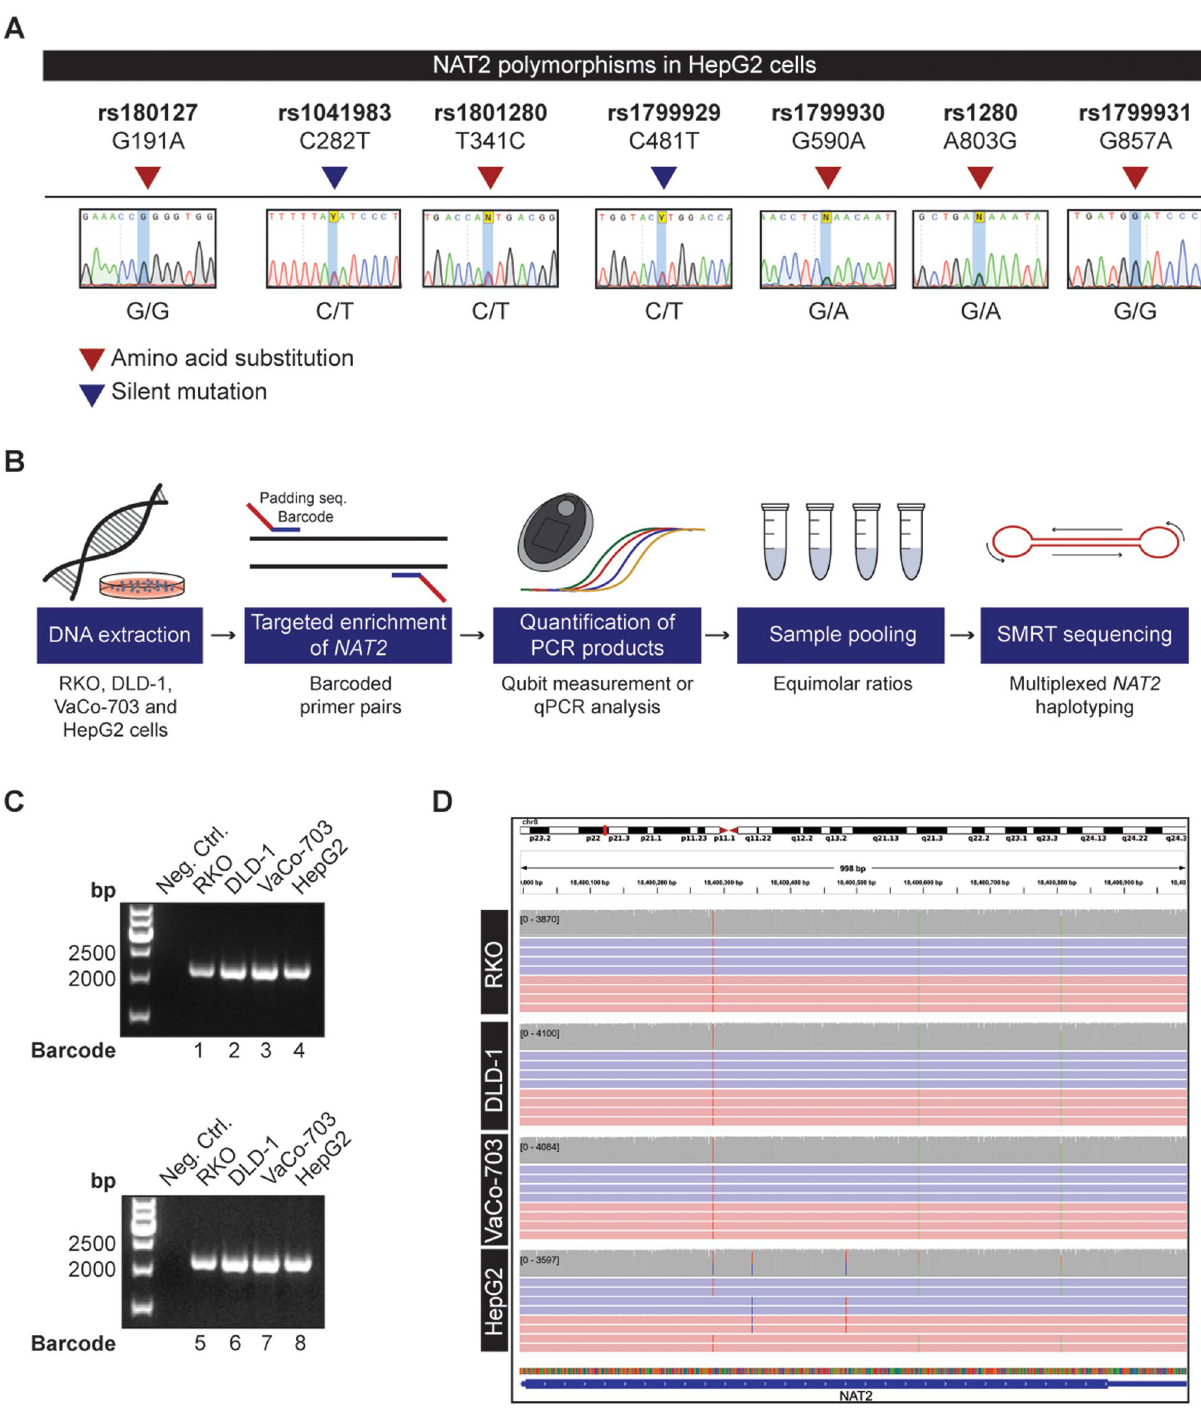
Figure 5. NAT2 haplotype resolution by multiplex SMRT sequencing. ( A ) Sanger sequencing does not allow the resolution of NAT2 haplotypes in samples that are polymorphic in more than one position. The genotype of HepG2 cells is shown for each of the seven standard positions used for NAT2 allele calling. ( B ) Workflow for multiplexed SMRT sequencing. Genomic DNA was extracted from the cancer cell lines to be haplotyped. The NAT2 region is amplified in each sample by using primer pairs with a unique barcode and a padding sequence. The resulting PCR products were quantified by Qubit measurements or qPCR analysis and pooled in equimolar ratios for multiplexed SMRT sequencing. ( C ) Barcoded PCR products resulting from NAT2 amplification in RKO, DLD-1, VaCo- 703 and HepG2 cell lines with two different sets of primers. Samples were run in a 1.5% agarose gel and water was used as a negative PCR control. Full-length gels are presented in Supplementary Fig. 4. ( D ) Visualization of the individual alleles present in RKO, DLD-1, VaCo-703 and HepG2 cell lines in Integrative Genomics Viewer. De-multiplexed SMRT sequencing reads from each cell line are aligned to the NAT2 reference sequence. Selection of reads in both positive (red) and negative (blue) direction supporting